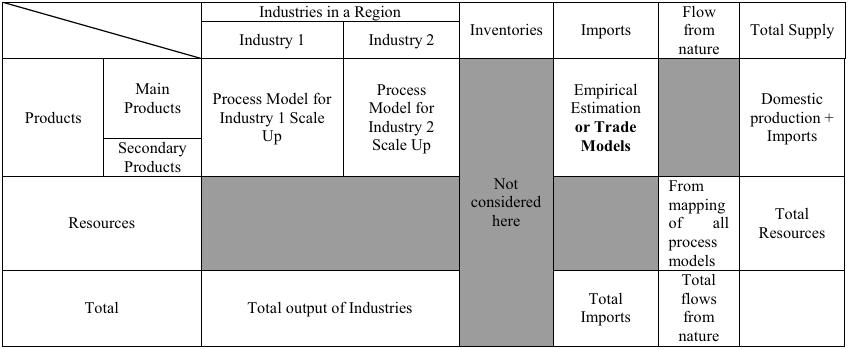
Table 1 Supply table for a region from process models and empirical data, modeled on SEEA 2012 (SEEA 2014)